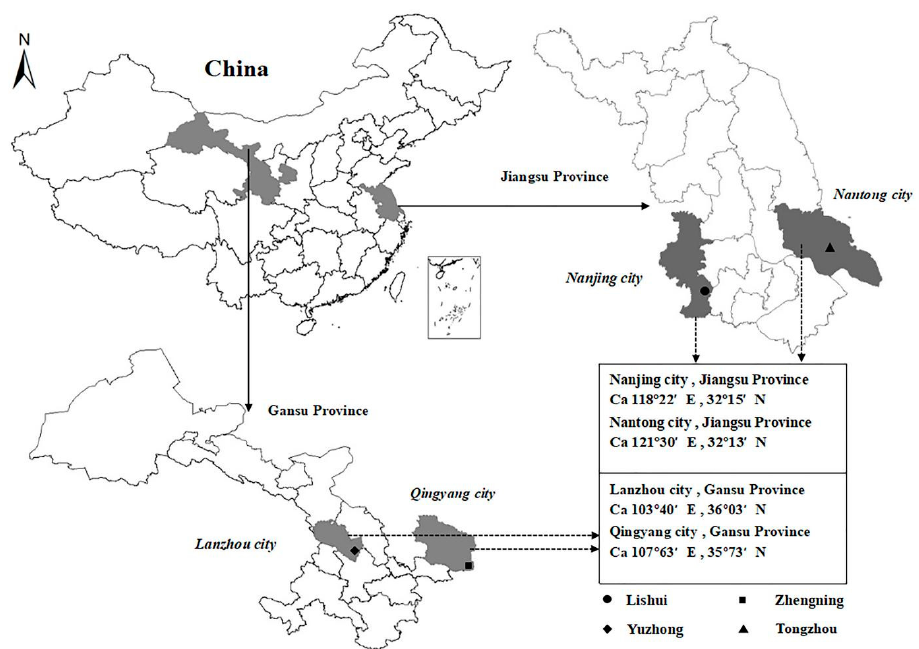
Figure 2. The geographical location of the study area.